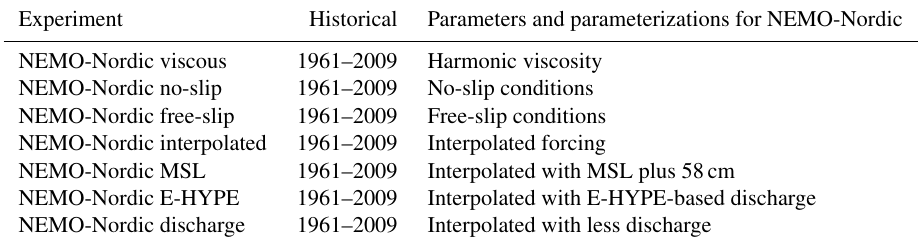
Table 7. Sensitivity runs that use different model parameters, parameterizations, mean sea level and river discharge. All runs in this table are ocean-only experiments. The sensitivity run NEMO-Nordic viscous uses constant lateral viscosity, while NEMO-Nordic no-slip uses coefficients according to Smagorinsky (1963). NEMO-Nordic free-slip differs by the slip conditions along lateral walls compared to NEMO- Nordic no-slip. In NEMO-Nordic MSL, the MSL is 58cm higher compared to NEMO-Nordic interpolated (see Table 5). NEMO-Nordic E-HYPE and NEMO-Nordic discharge differ by the river discharge, which is O(1500m 3 a − 1 ) higher in NEMO-Nordic E-HYPE and which is used in all other